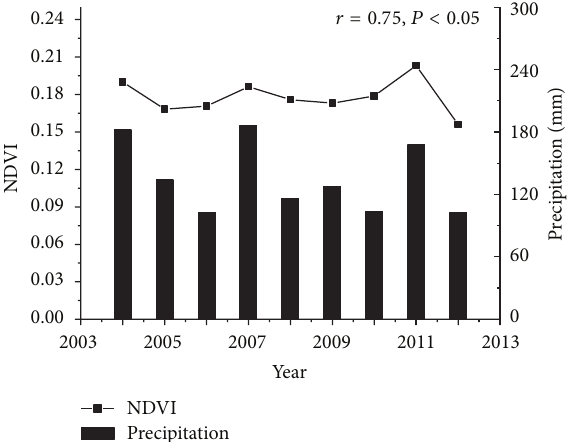
Figure 3: Total annual precipitation and mean NDVI during the growing season for the shrubland within Gurbantunggut Desert.